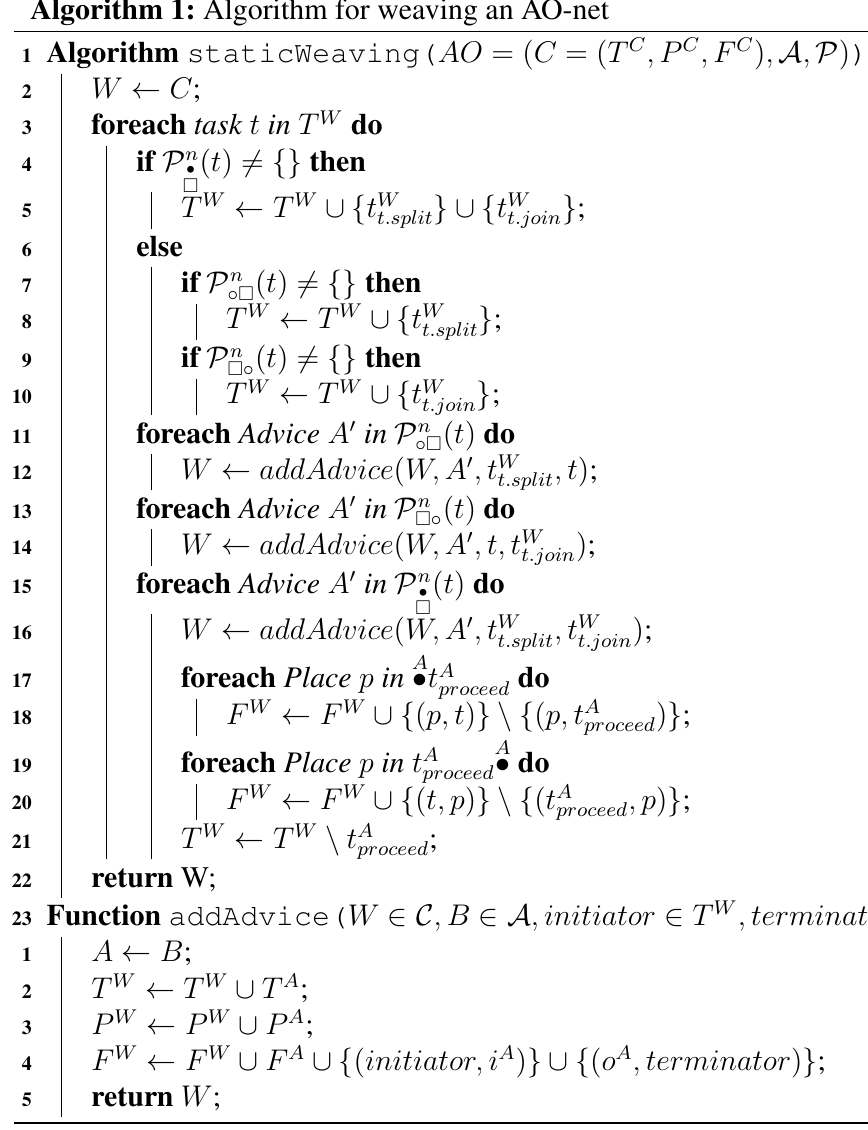
Algorithm 1: Algorithm for weaving an